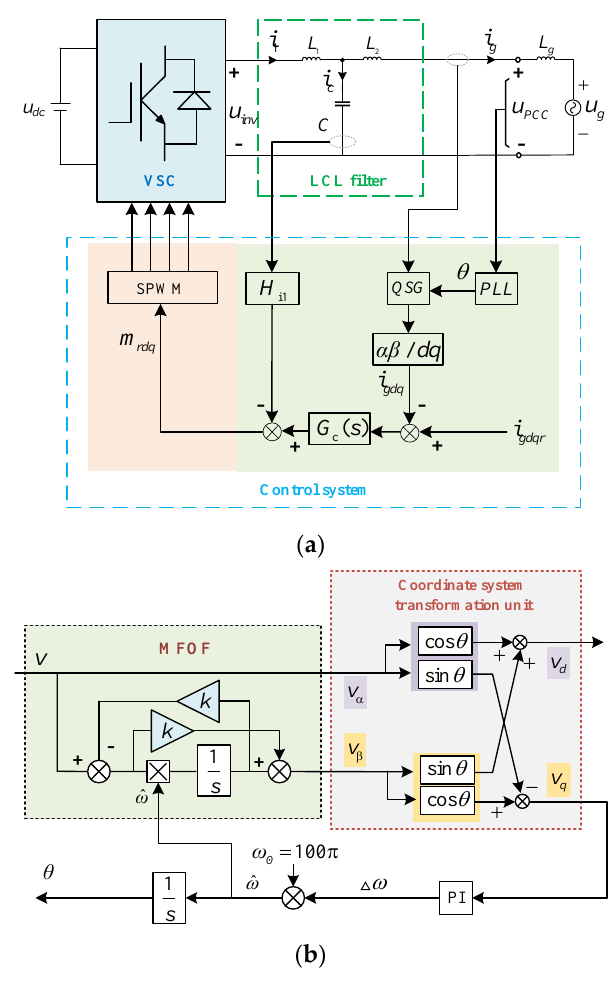
Figure 1. Structure and model of single-phase grid-connected inverter: ( a ) the control block diagram of the single-phase LCL-type grid-connected inverter; ( b ) the control diagram of MFOF-PLL.